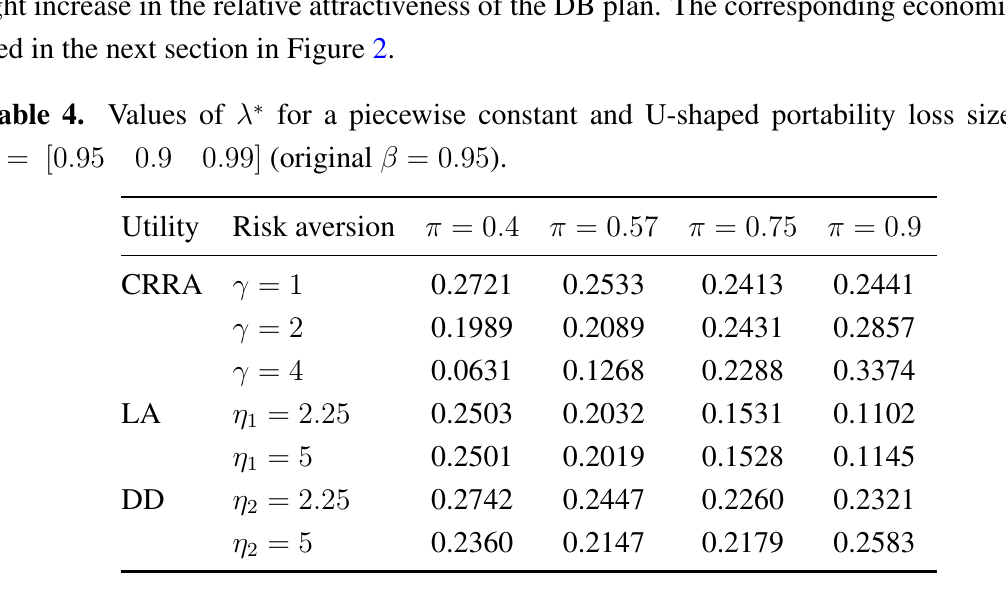
Table 5. Values of λ ∗ for a piecewise constant and decreasing salary trend with